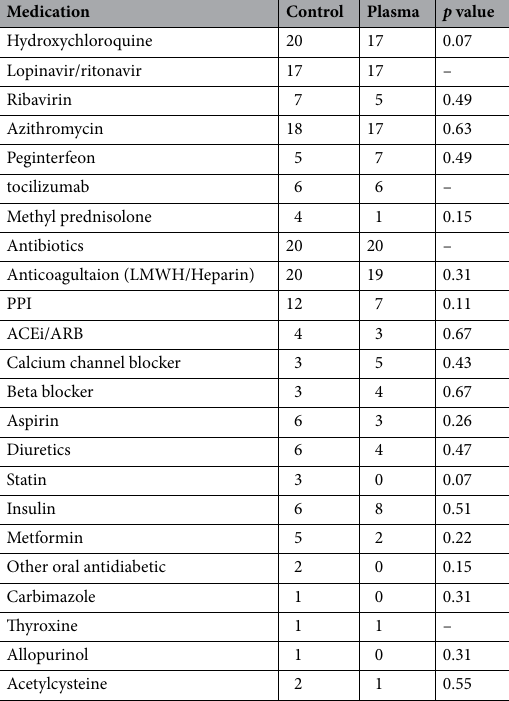
Table 2. Medication given after randomization.